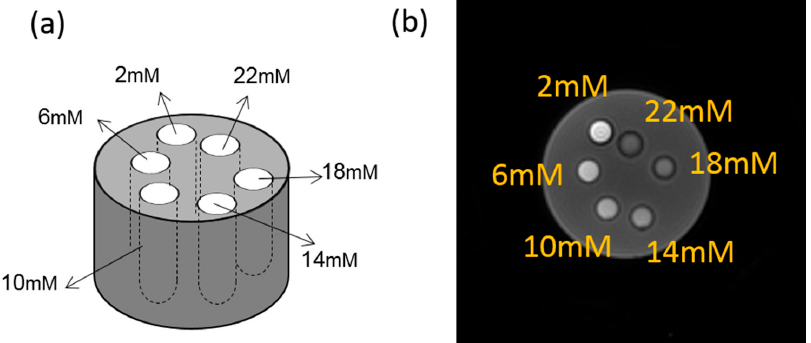
Figure 2. ( a ) Demonstration of the phantom design. ( b ) Typical magnitude image of the first echo with the UTE-Cones sequence at TE = 32 μ s.